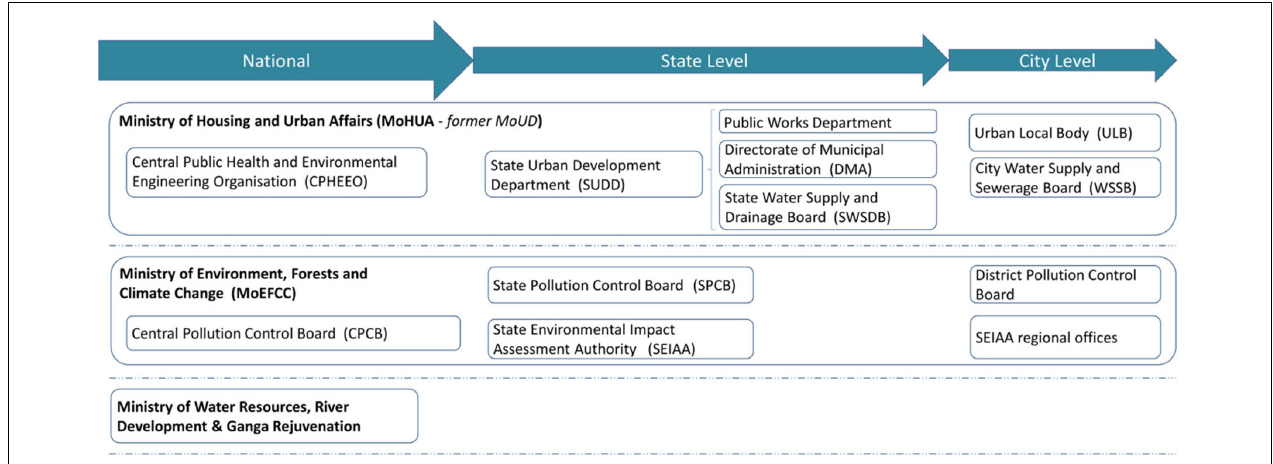
FIGURE 1 | Government agencies responsible for urban wastewater management in India (in January